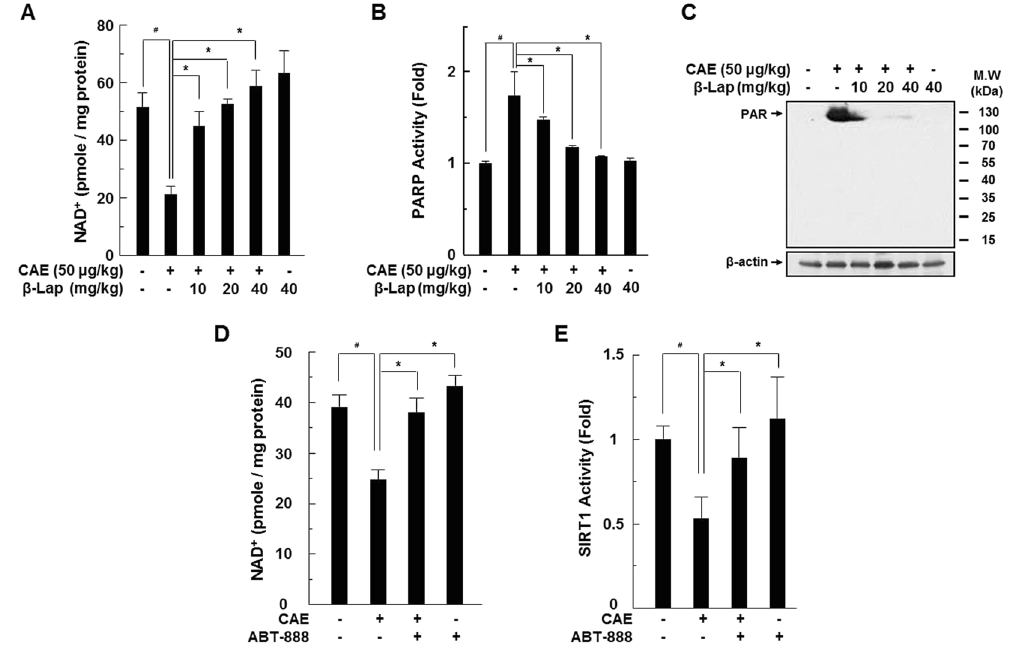
Figure 3. Effect of β -Lap on pancreatic NAD + levels in WT mice during caerulein-induced AP. ( A ) NAD + and NADH were extracted from pancreatic tissues, and changes in NAD + levels were measured using the NAD + / NADH assay kit. ( B ) PARP activity was assayed using the PARP assay kit. ( C ) PARP-1 activation was analysed by western blotting using anti-PAR. ( D , E ) Isolated acinar cells were treated with the PARP inhibitor, ABT-888 (1 μ M), and caerulein (1 μ M) for 24 h, and then the NAD + level and SIRT1 activity were measured using the NAD + /NADH assay kit and SIRT1 assay kit. Each value represents the mean ± SD ( n = 5). * P <